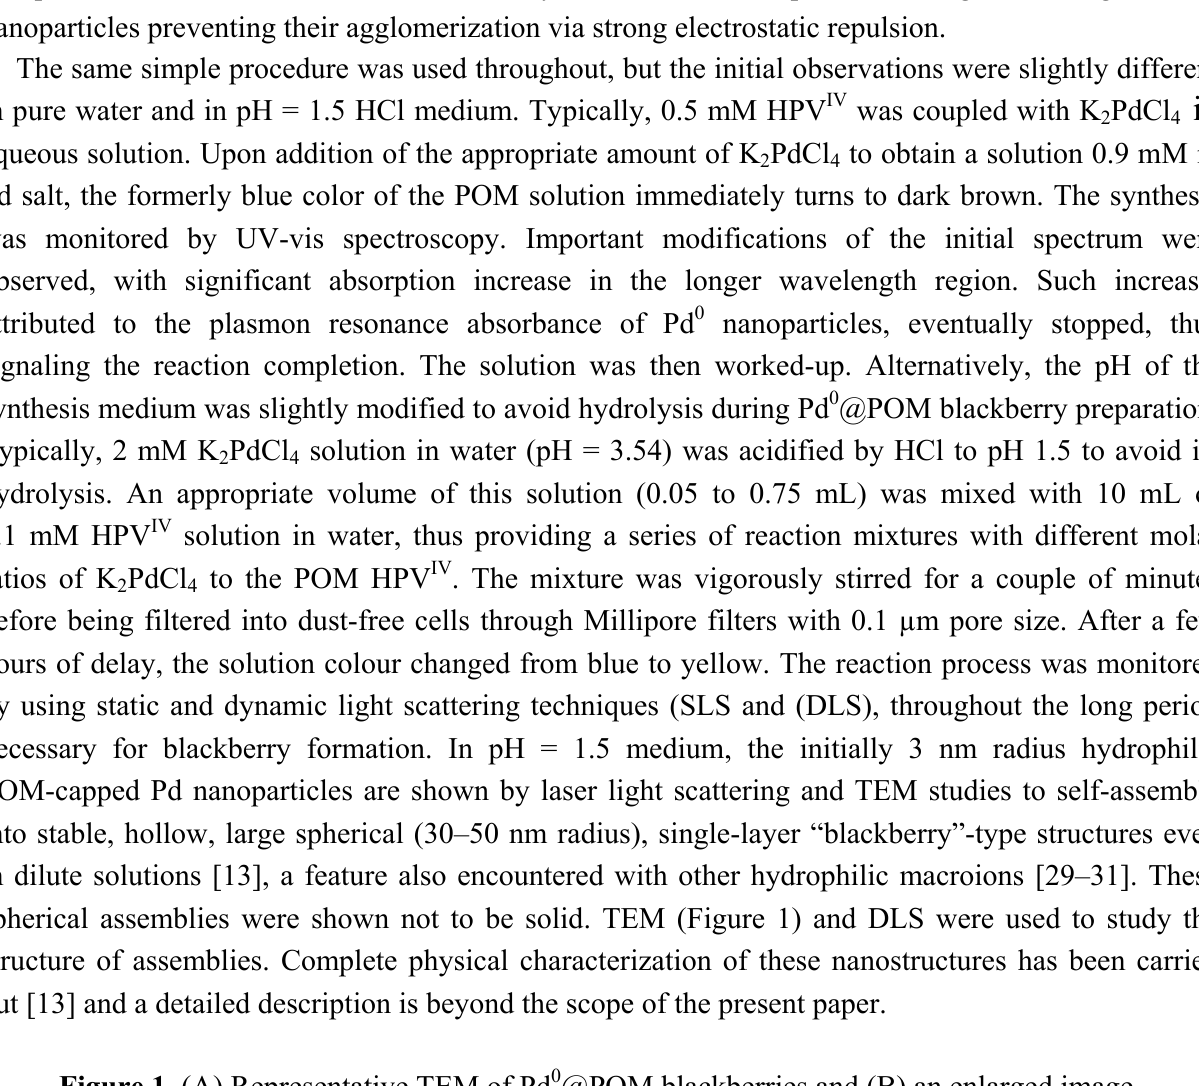
Figure 1. (A) Representative TEM of Pd 0 @POM blackberries and (B) an enlarged